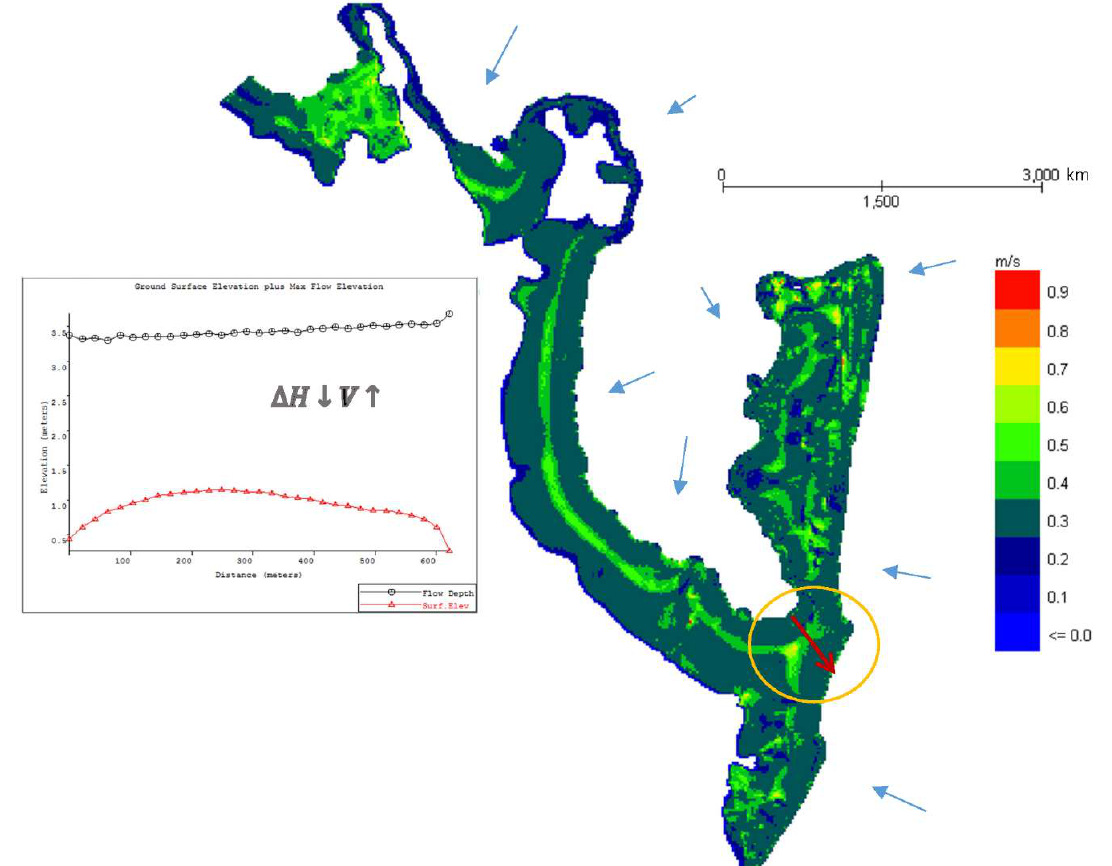
Figure 11. Map of maximum storm surge velocity (ms − 1 ). Storm surge inland flow direction is shown with blue arrows. Inset panel shows surface elevation versus storm surge height, with velocity of transect (red arrow) increasing as ∆H decreases.